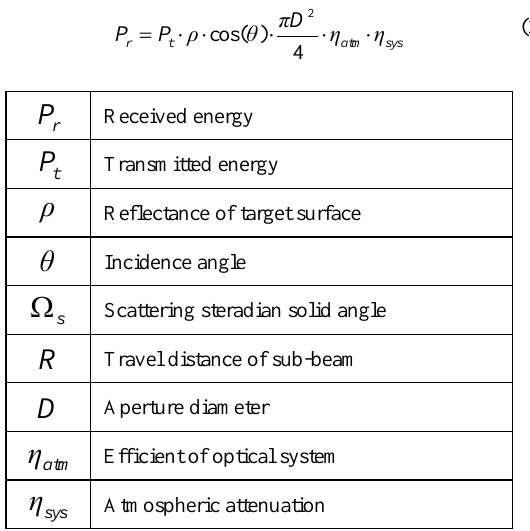
Table 2. Description of variables of laser range equation